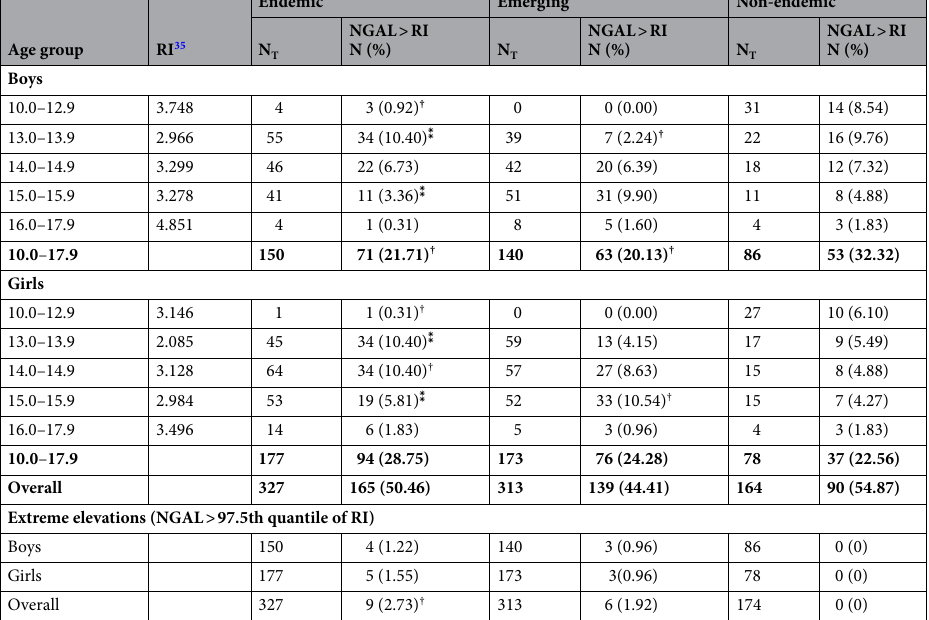
Residential CKDu prevalence